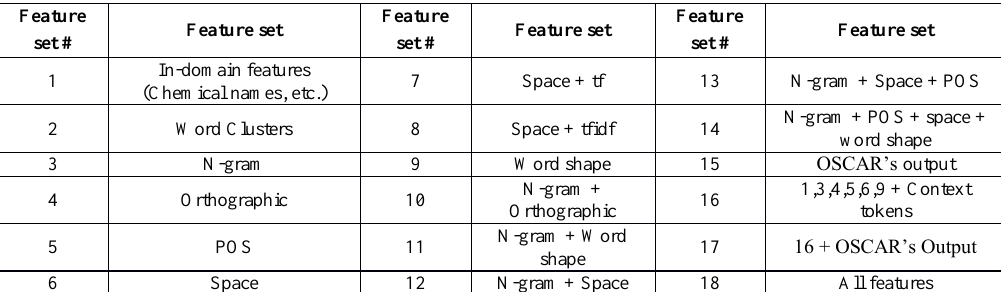
Table 2. Feature sets used.